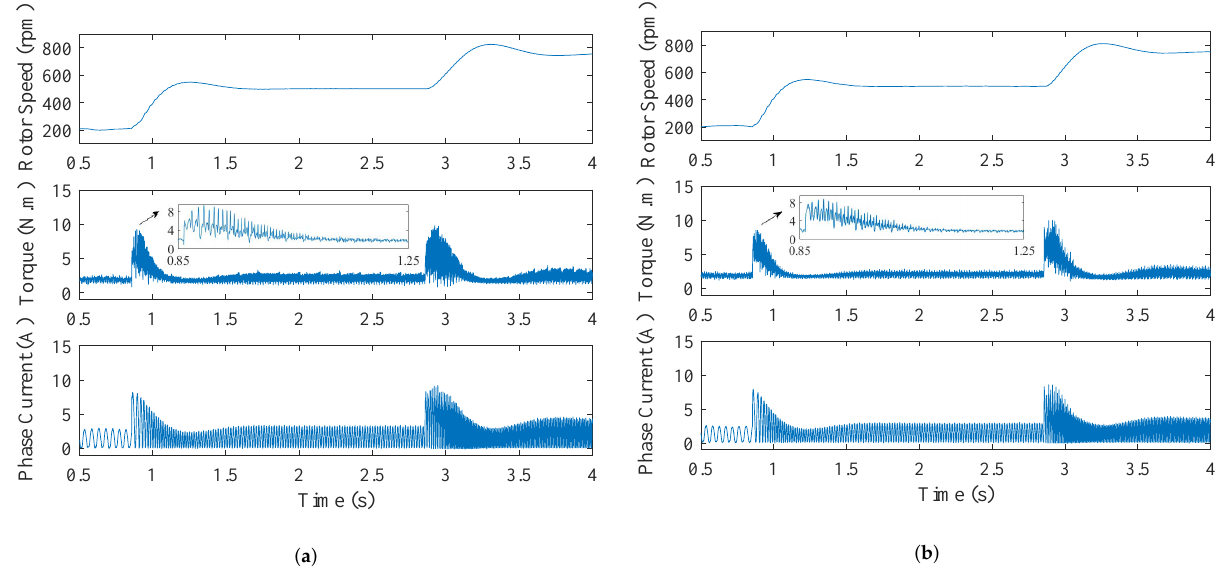
Figure 7. Experimental results of the rotor speed, total torque and phase current when the speed changes. ( a ) Method in [14]. ( b ) 2DOF IMC ADO